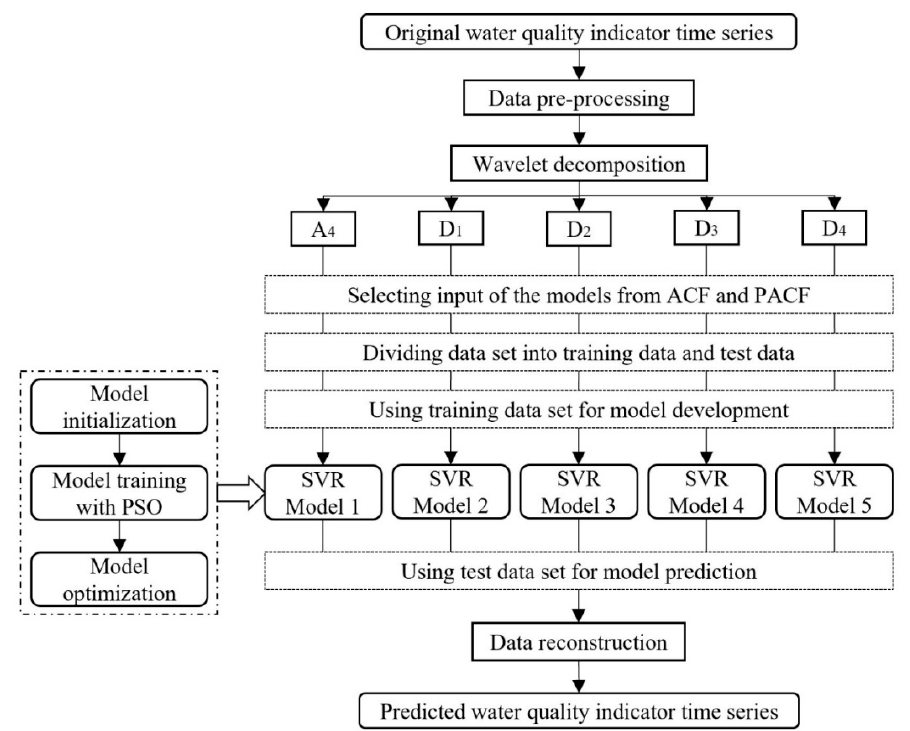
Figure 3. Flow chart of the wavelet analysis-support vector regression approach with particle swarm optimization algorithm (WA-PSO-SVR) structure for the prediction of water quality indicators. 1.